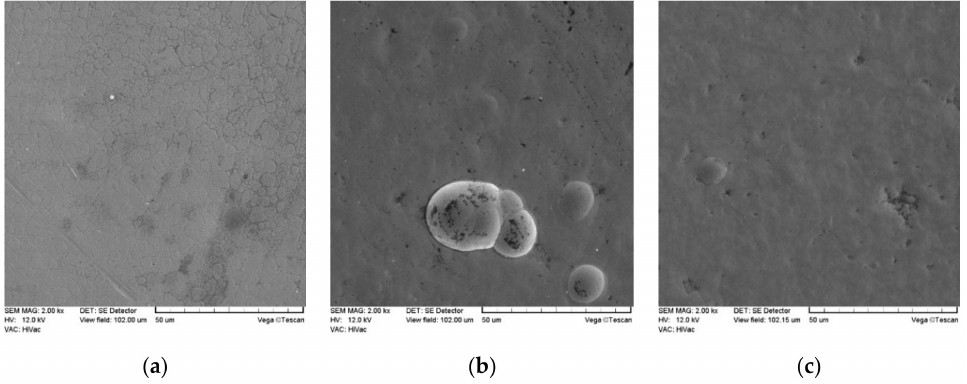
Figure 3. SEM images of the morphology of Ni-P and Ni-P / Si 3 N 4 layers; ( a )—Ni-P, ( b )—Ni-P / Si 3 N 4